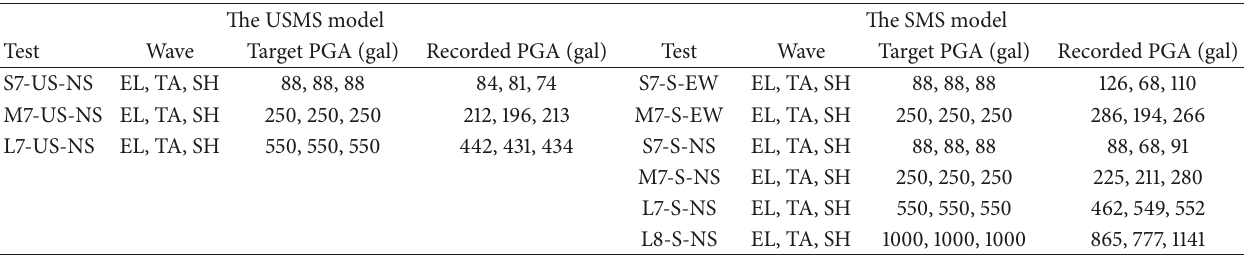
Figure 6: The proposed elastic response spectrum and the response spectrums obtained from the compressed accelerograms. Table 2: Test sequences for experimental models.